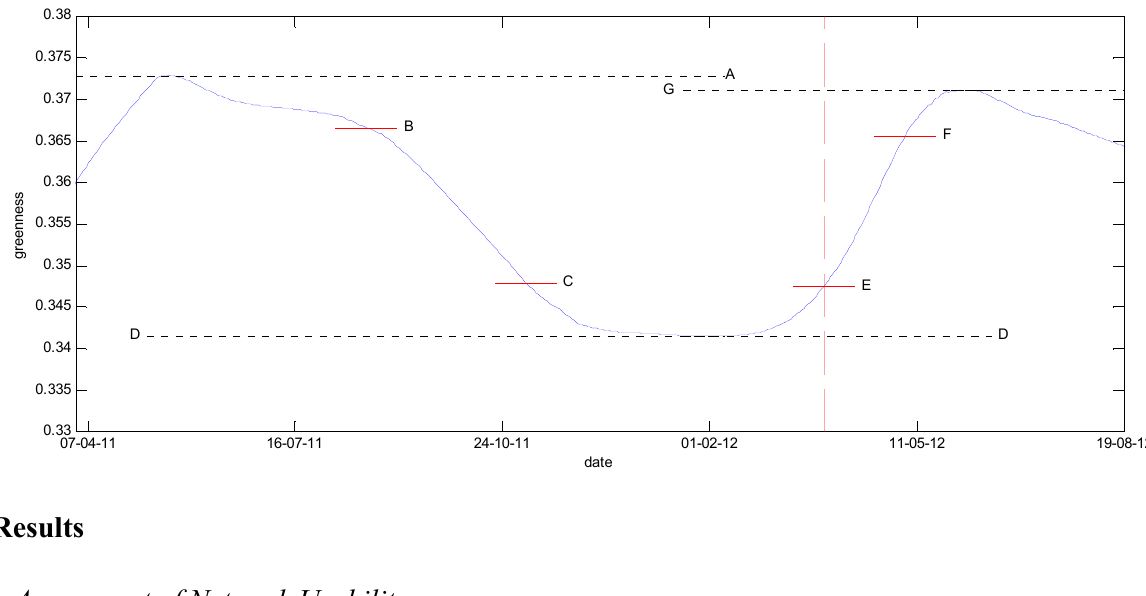
Figure 3. Graphical description of the determination of phenological dates. A, season maximum; B, start of senescence, 80% between D and A; C, end of senescence, 20% between D and A; D, inter-seasonal minimum; E, start of leaf-up, 20% between D and G; F, end of leaf up, 80% between D and G; G, season maximum. Vertical lines show intersections for date